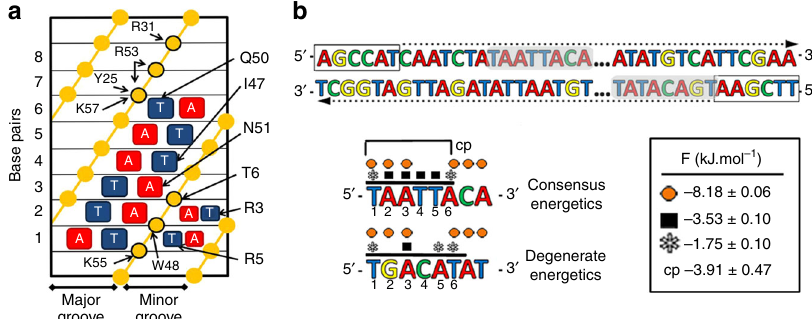
Fig. 3 Statistical mechanical model to describe the DNA-binding modes of EngHD. a Scheme of the various interactions existing between EngHD and DNA as observed in the 3D structure of the EngHD-DNA complex (based on ref. 40 , PDB: 1HDD). b (top) Representation of how the statistical mechanical model calculates all possible binding events using a 6-bp sliding window that runs 5 ′ – 3 ′ through both strands. (bottom) detailed binding energetics for the two exemplary binding sites selected from the top (shown on top as gray boxes). The upper example includes all the speci fi c binding interactions of a full consensus site, and the lower is an example of a degenerate consensus site. The model and interactions are described in the text, and the parameters obtained after global optimization against all experimental data (Figs. 2, 4 and 5) together with their statistical signi fi cance (one standard deviation) are given in the box. Black symbols correspond to consensus core tetrad interactions ( Δ G ), gray asterisks correspond to degenerate consensus consensus ; core interactions with A or T ( Δ G ). Orange circles correspond to electrostatic (nonspeci fi c) interactions, which extend over 8-bp ( Δ G ) and cp is the degenerate ; AT elec cooperative interaction that takes place when the site includes the full consensus sequence (2 Δ G ; see model cp